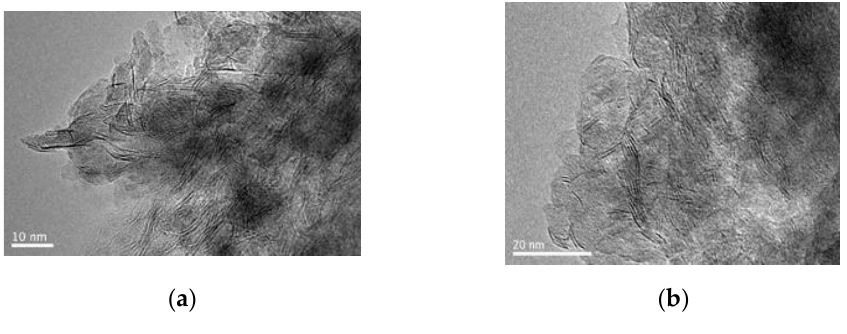
Figure 5. HRTEM images of sulfide catalysts ( a ) CAT3 and ( b ) CAT7. Table 5. The average particle length ( 𝐿̅ ) and stacking number ( 𝑁̅ ) of CAT3 and CAT7.